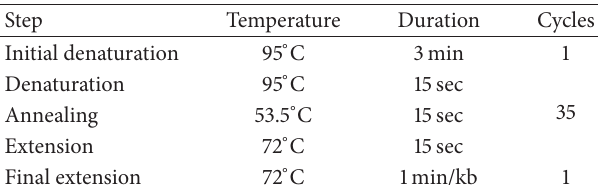
Table 1: PCR amplification